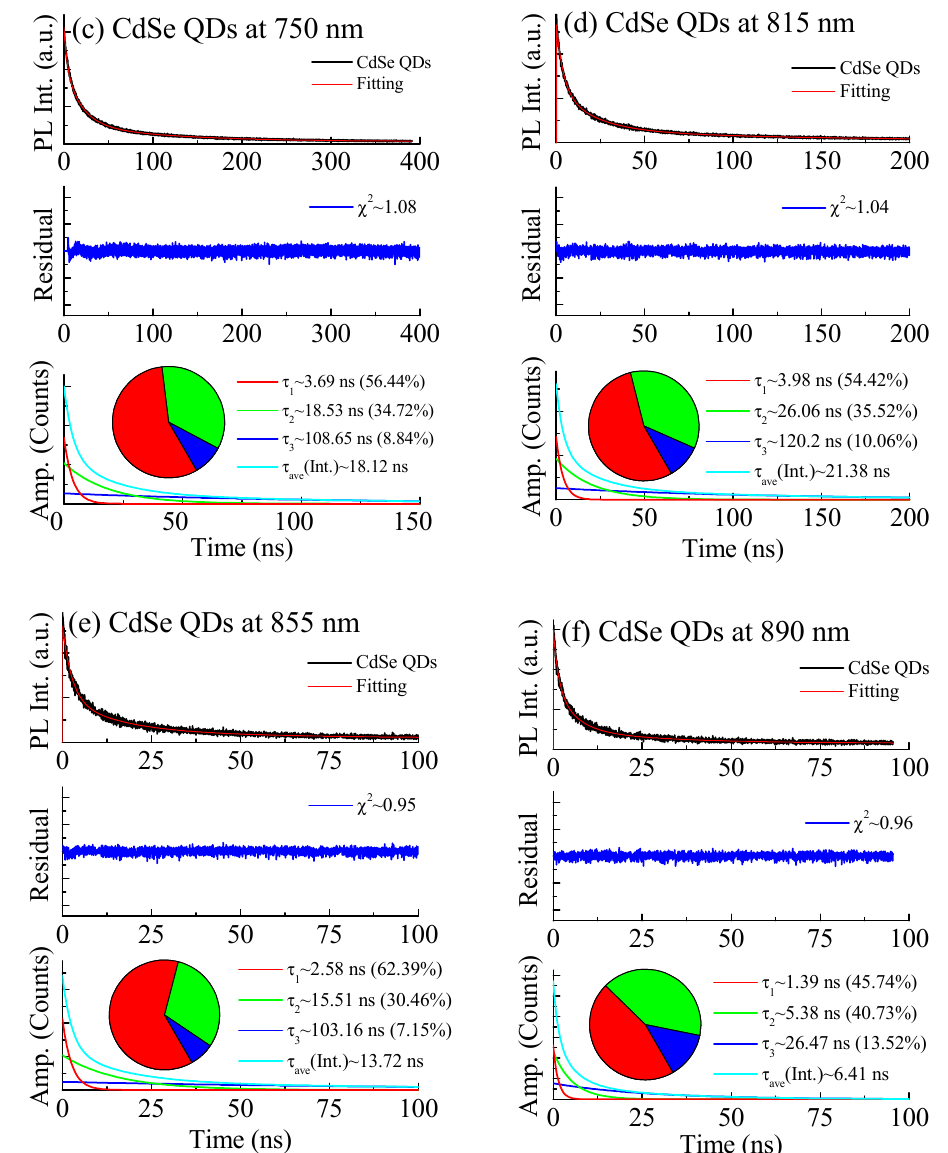
Figure 3. Time resolved PL of CdSe QDs at ( a ) 575 nm, ( b ) 675 nm, ( c ) 750 nm, ( d ) 815 nm, ( e ) 855 nm, and ( f ) 890 nm.